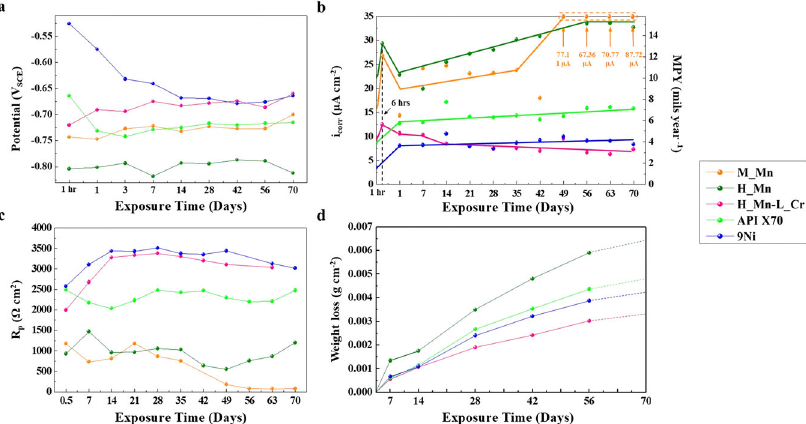
Fig. 2 Long-term corrosion behaviors of the fi ve tested samples. a OCP evolution. b Change in i corr and mpy , obtained by the LPR measurements. c Change in R p , obtained by the EIS measurements. d Weight loss, measured after the immersion